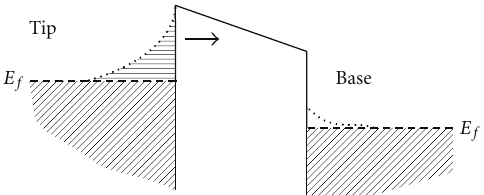
Figure 5: Thermal asymmetry of the tunnel current caused by the tip temperature greater than the base temperature for forward bias. The broader thermal spread of the electron distribution of the planar cathode should result in a higher forward bias current [12].